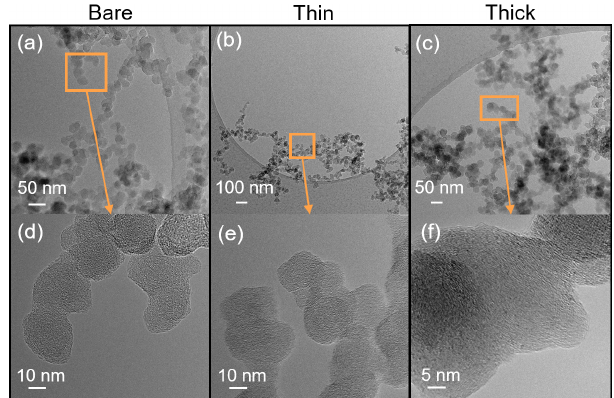
Figure C4. HR-TEM images for fine structures of 200nm size- selected bare and coated mCASTblack soot particles. Scale bars are indicated in each image. (a, d) Bare particles, (b, e) thinly coated particles with a coating wt = 2.9%, and (c, f) thickly coated parti- cles with a coating wt = 30.2%. All images taken with TFS F30.